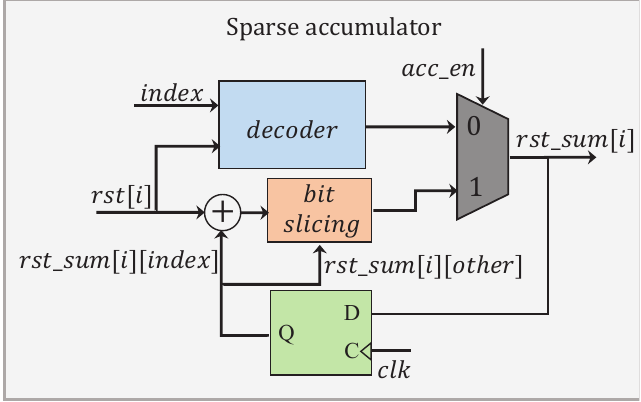
Figure 15. Block diagram of the sparsity-aware